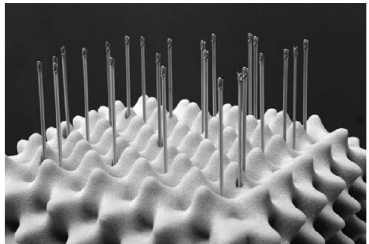
Figure 1. Virtual arti fi cial head (VAH) in this study: planar microphone array with 24 microphones and an extension of 20 cm (cid:1) 20 cm